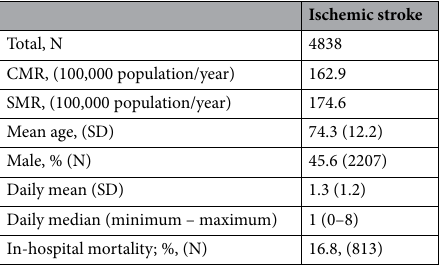
Table 1. Ischemic stroke morbidity in Bialystok in the years 2010–2020. CMR, crude morbidity rate per 100,000 population per year; SD, standard deviation; SMR, standardized morbidity rate per 100,000 population per year.